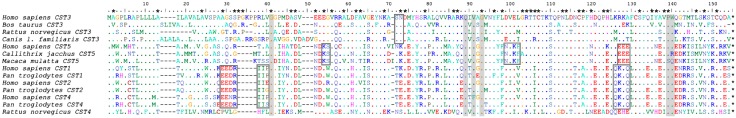
Amino acid composition of cystatins.
Homo sapiens cystatin C (P01034); Bos taurus cystatin C (P01035); Rattus norvegicus cystatin C (P14841); Canis lupus familiaris cystatin C (J9NS29); Homo sapiens cystatin D (P28325); Callithrix jacchus cystatin D (ENSCJAP00000001156); Macaca mulatta cystatin D (G7N352); Homo sapiens cystatin SN (P01037); Pan troglodytes cystatin SN (H2QK35); Homo sapiens cystatin S (P01036); Pan troglodytes cystatin S (H2QK34); Homo sapiens cystatin SA (P09228); Pan troglodytes cystatin SA (H2QK36) and Rattus norvegicus cystatin S (P19313). Filled grey boxes indicate conserved amino acid motifs; empty boxes indicate conserved amino acids characteristic of each cystatin; asterisks (*) mark the codons on CST3 under negative selection.